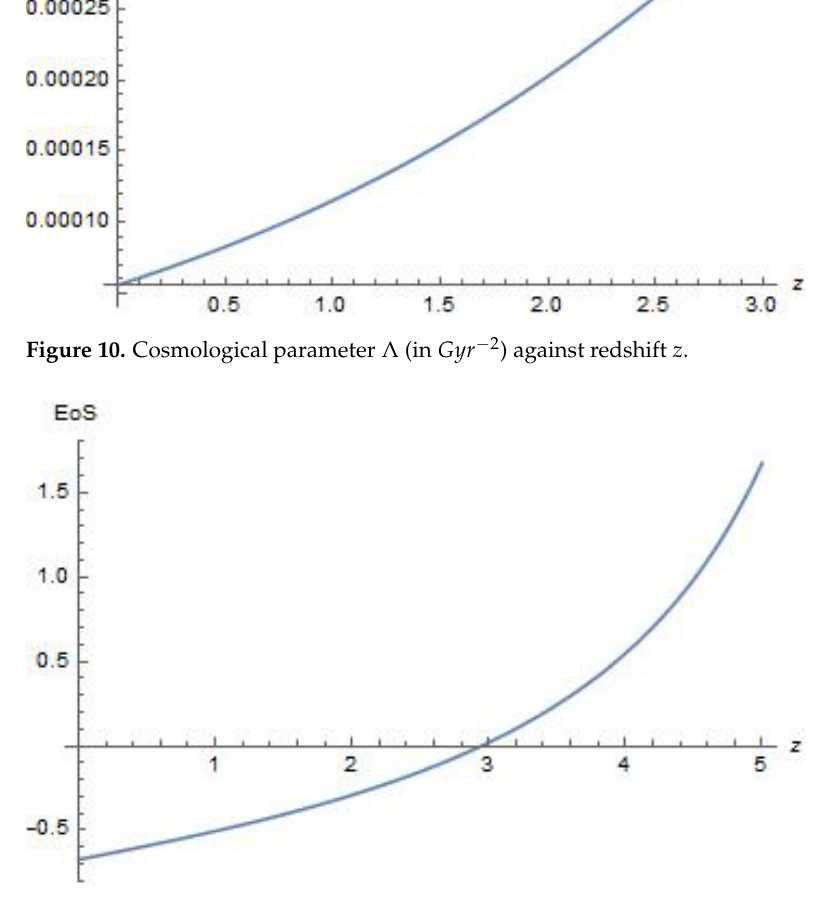
Figure 11. Equation of state parameter ω against redshift z